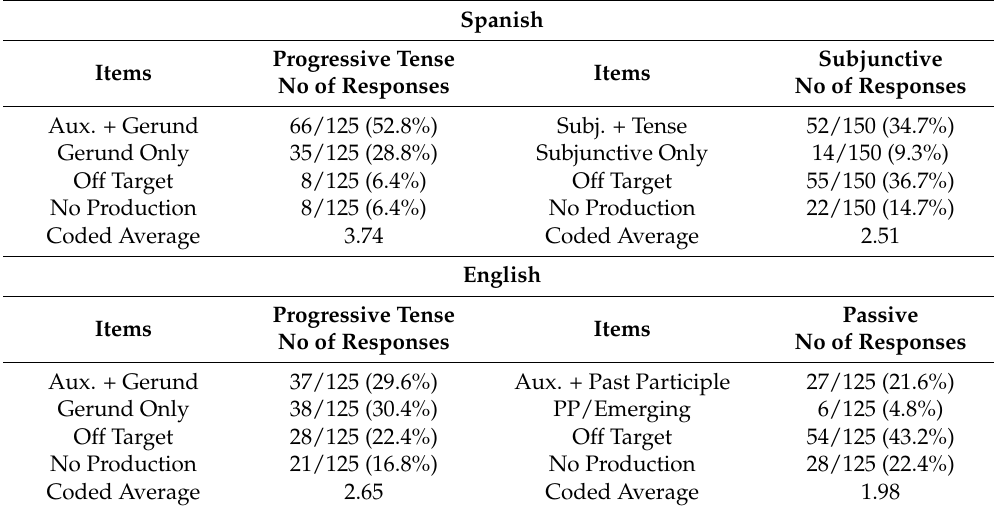
Table 6. KDG Proportion of Responses for Spanish–English Structures.